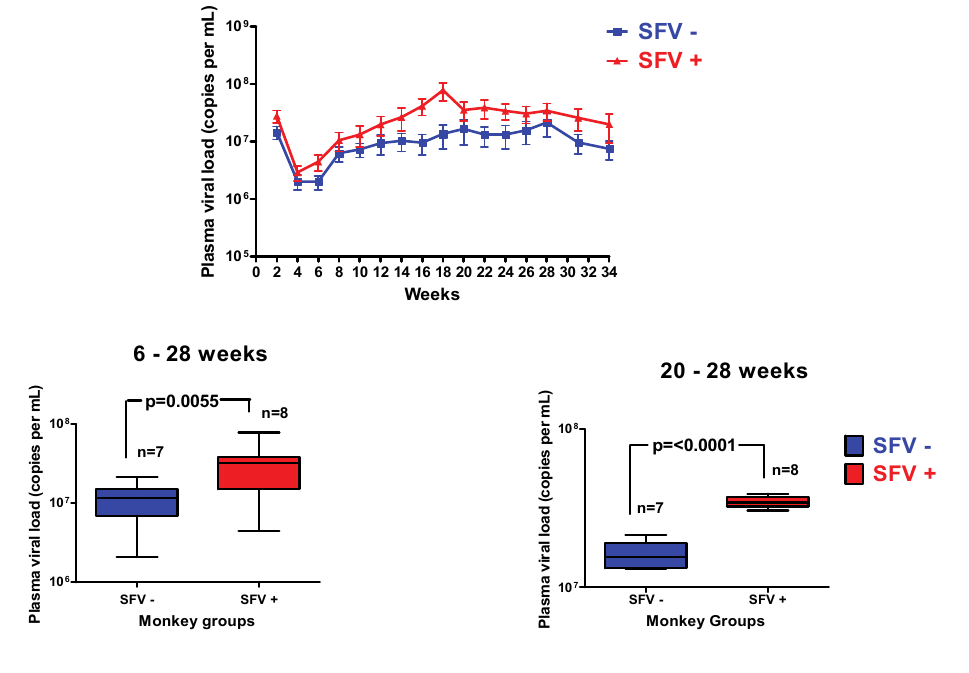
Figure 4. SIV viral load analysis. Plasma viral load was determined at the indicated times by bDNA from weeks 2 through 34. Mean ± SEM of the results from SFV+/SIV+ and SFV − /SIV+ monkey groups was plotted 2–34 weeks. Box and whiskers analysis of the plasma viral load from 6–28 weeks and 20–28 weeks for the SFV positive and SFV negative monkey groups is shown; p values and number of animals in each group are